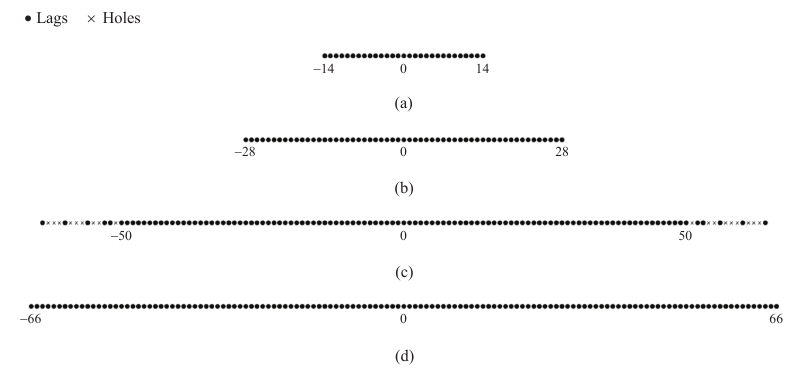
Figure 6. Four virtual configurations ( R = 15): ( a ) the traditional NC virtual array for the ULA; ( b ) the diff–sum coarray for the ULA; ( c ) the diff–sum coarray for the CAMpS with ( M , N , P 1 , P 2 ) = ( 4,3,2,3 ) ; and ( d ) the diff–sum coarray for the DsCAMpS with ( M , N , P